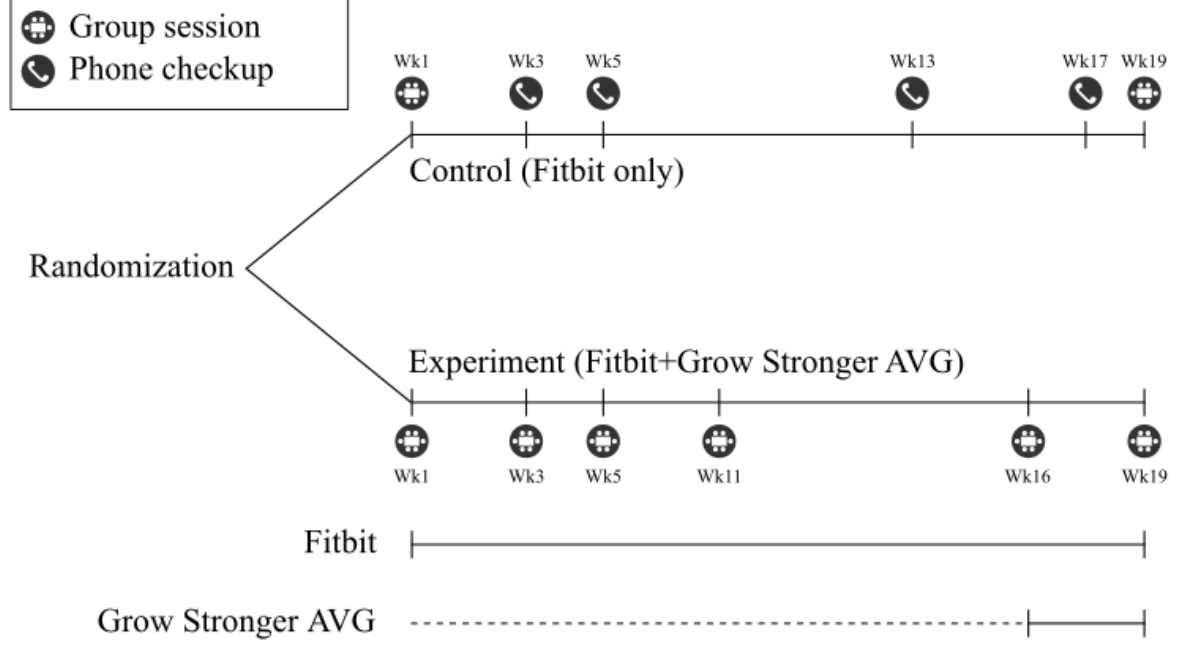
Figure 1. Contact times, types of contact, and interventions received for each group. Group sessions for the experiment group comprised focus groups in the co-design process along with an install session in week 16, whereas the 2 group sessions for the control group were a group enrolment session in the first week and a study conclusion session in the final week. AVG: active video